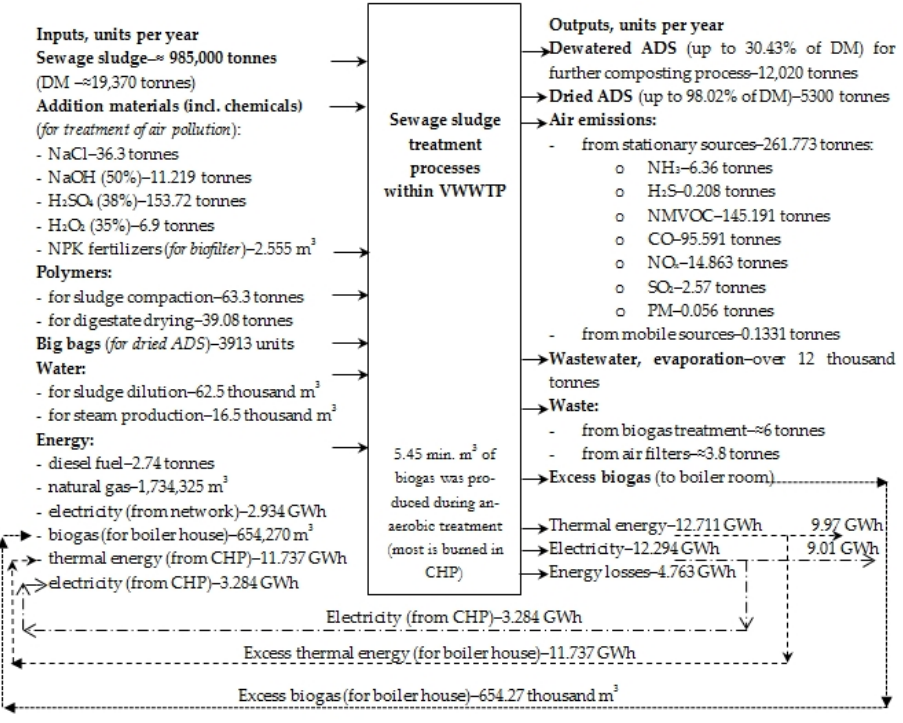
Figure 1. Main material and energy inputs and outputs of sewage sludge treatment processes (current situation).